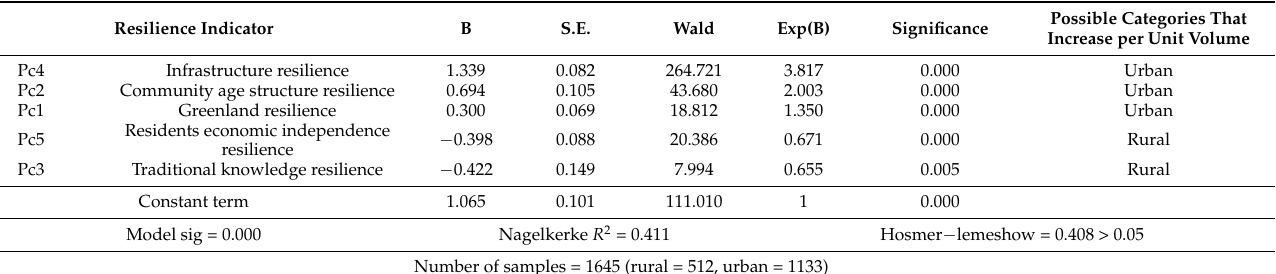
Table 2. Binary logistic regression model